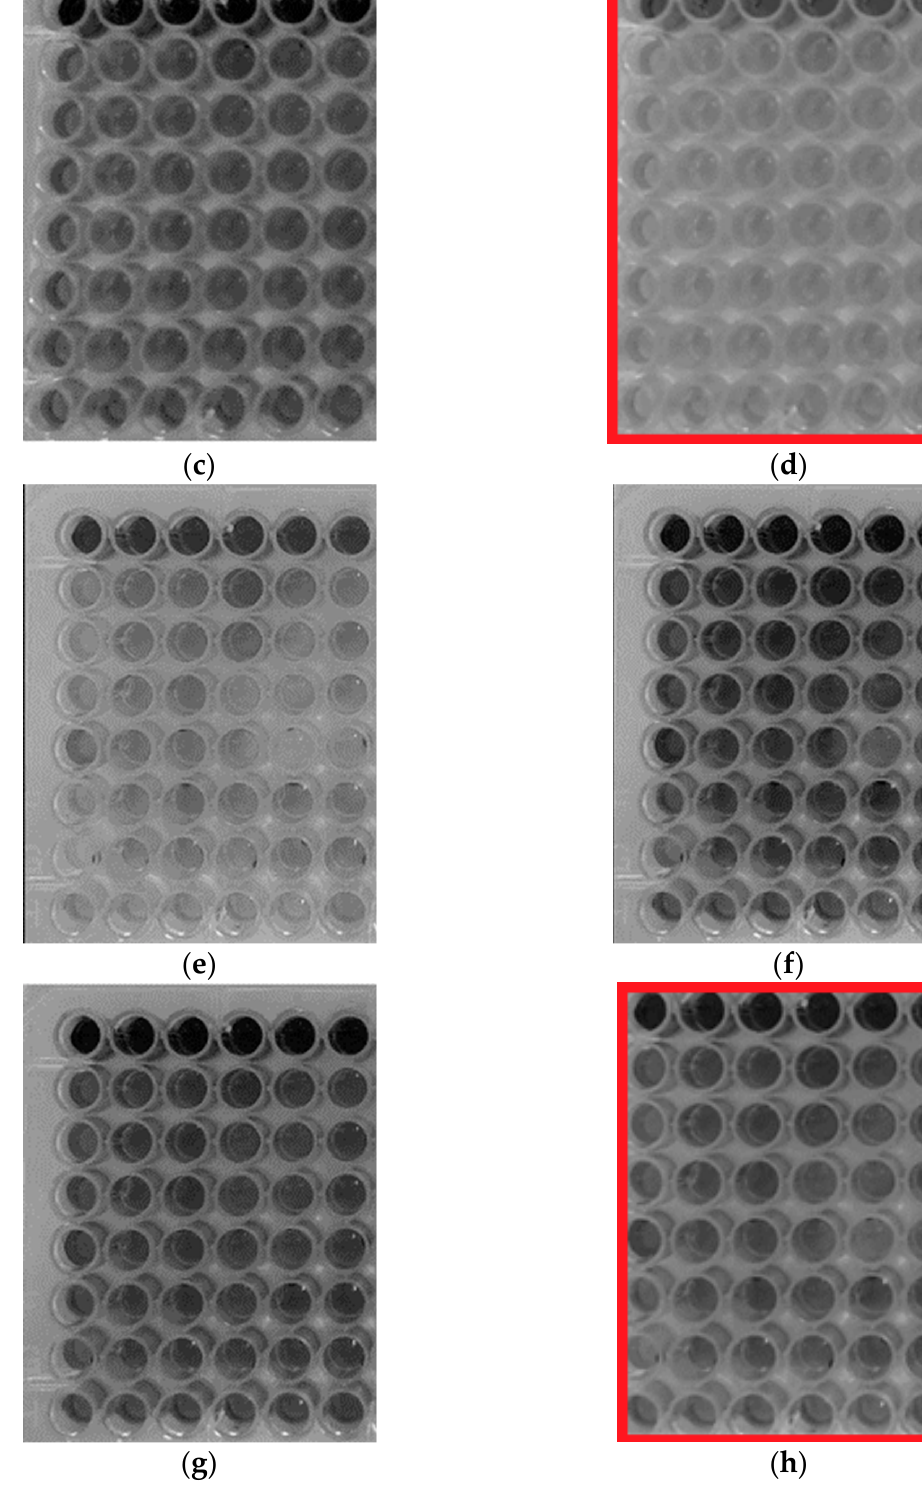
Figure 2. Images from the plate with the 1199 strain, before the addition of resazurin (0.4 mg/mL); ( a ) red, ( b ) green, ( c ) blue and ( d ) image resulting from the convex linear combination. Images from the plate with the 1199 strain, after the addition of resazurin (0.4 mg/mL); the ( e ) red, ( f ) green, ( g ) blue channels and ( h ) image resulting from the convex linear combination.